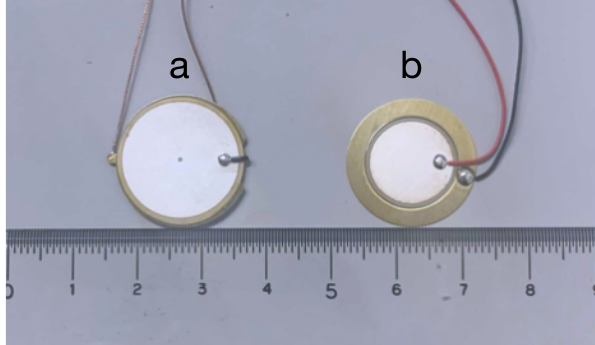
Figure 5. ( a ) Contact speaker and ( b ) contact